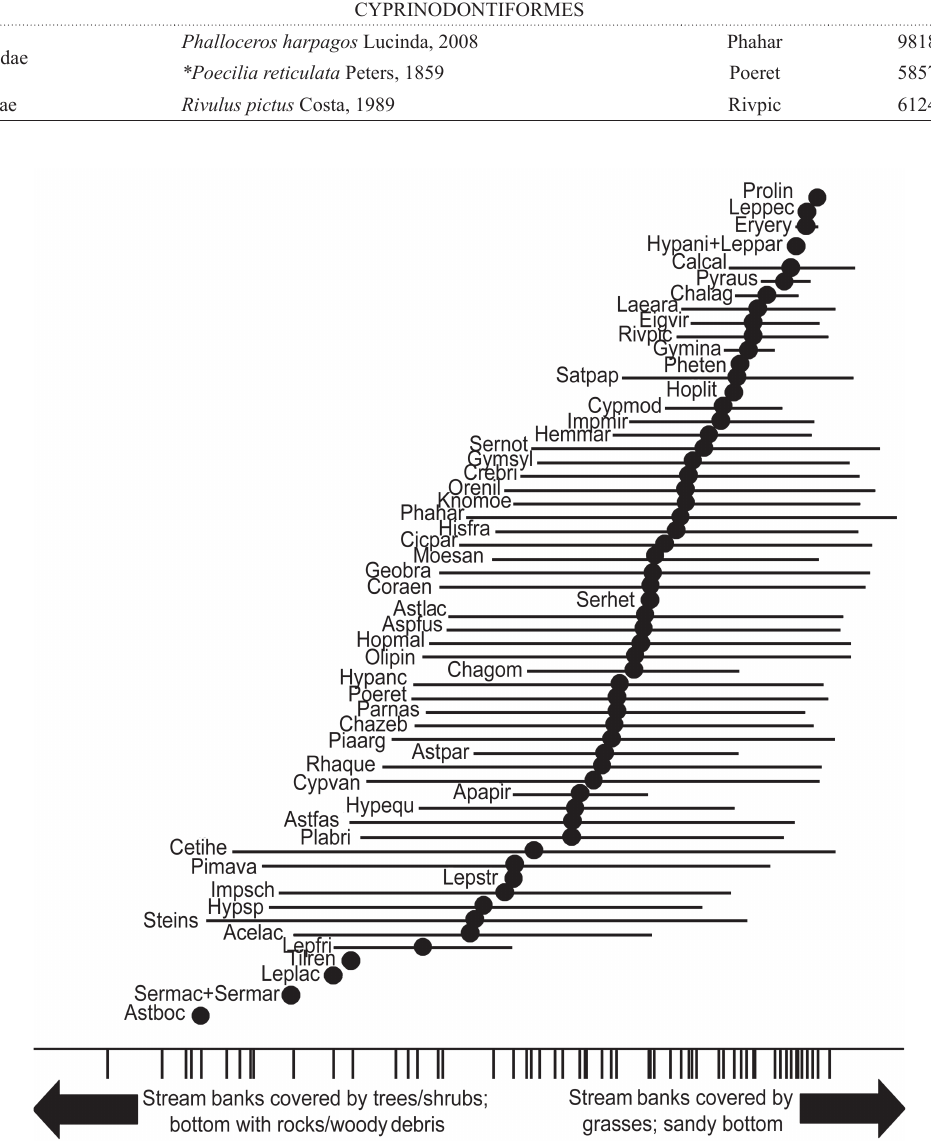
Fig. 2. Average position of species occurrence along the gradient of habitat structure (dark circles). The horizontal bars indicate the standard deviation of the mean position of each species, and the vertical bars at the bottom of the graph represent the position of each stream along the habitat gradient (axis 1 of RLQ). Species codes are presented in Table